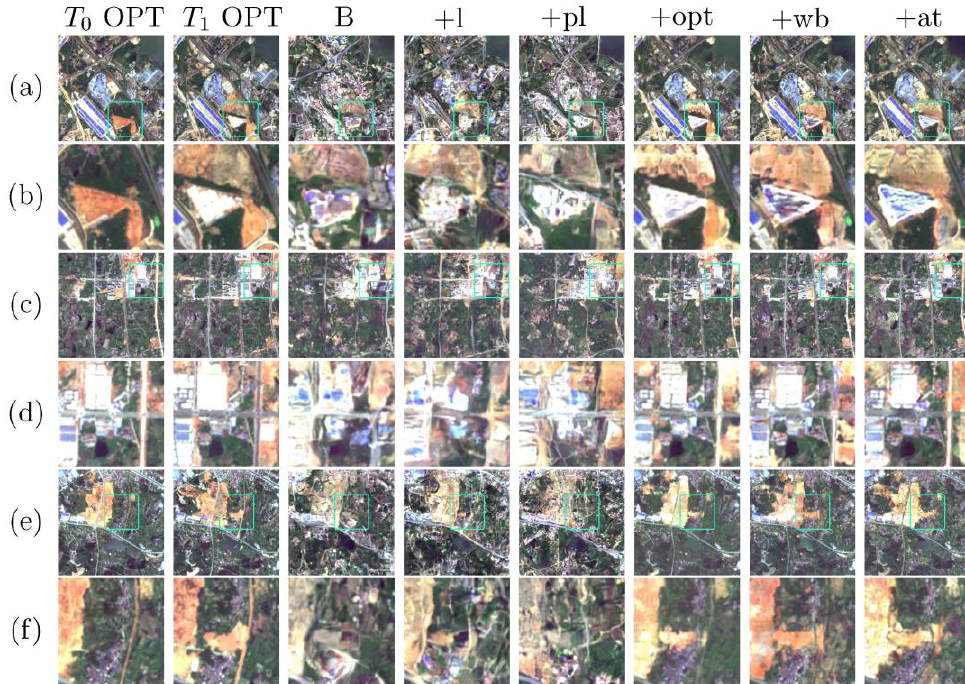
Figure 14. Visual inspection of the ablation study. Columns three to eight show the results of B, B + l, B + l + pl, B + l + pl + opt, B + l + pl + opt + wb, and B + l + pl + opt + wb + at, respectively. Three